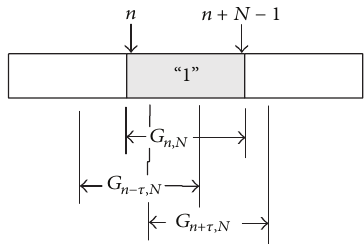
Figure 15: Example of an audio clip with 3 frames and three segments from which trajectory matrices are